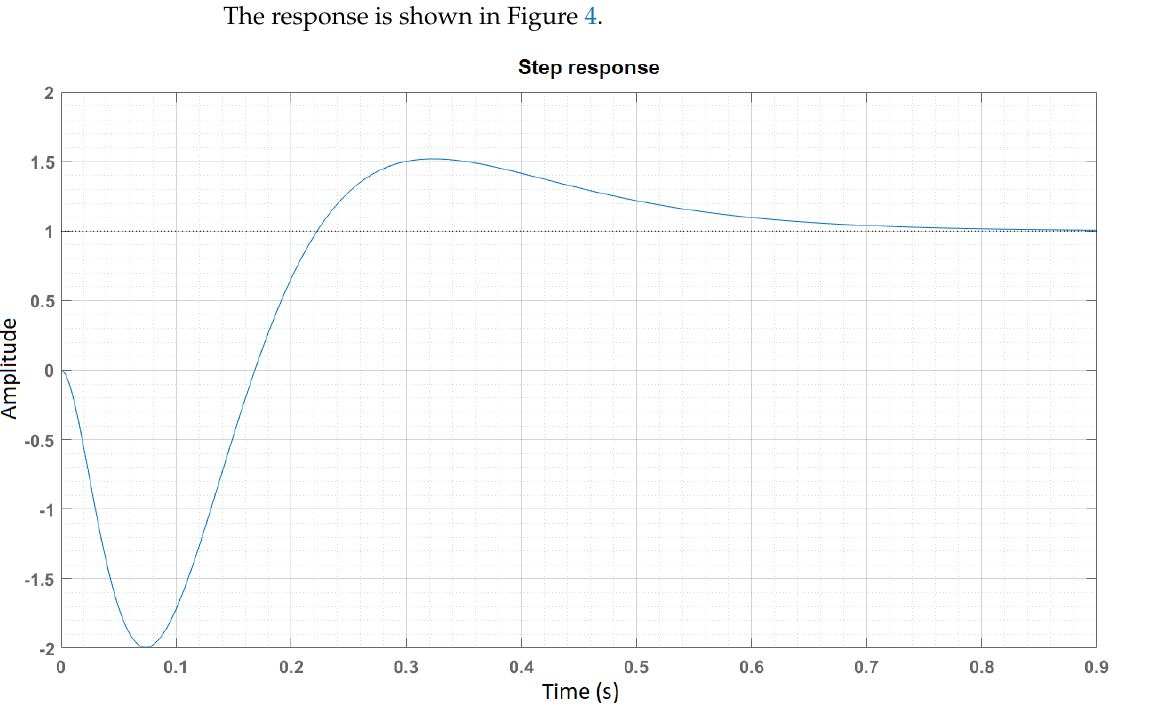
Figure 4. Pole placement